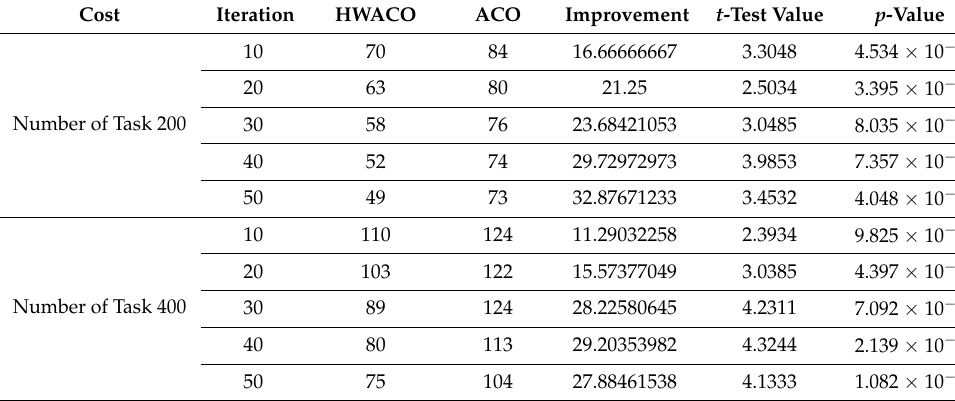
Table 11. t -Test for cost between HWACO and